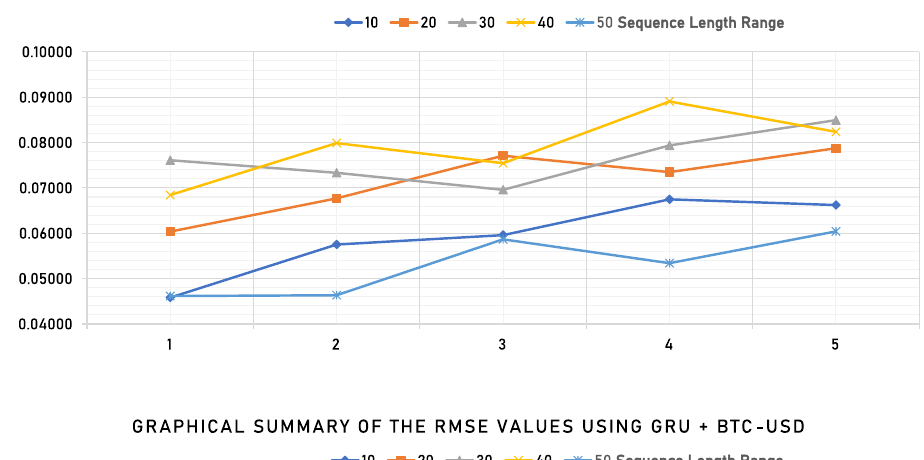
Fig. 9 A graphical summariza- tion of the reported results using GRU and “Bitcoin USD (BTC-USD)”